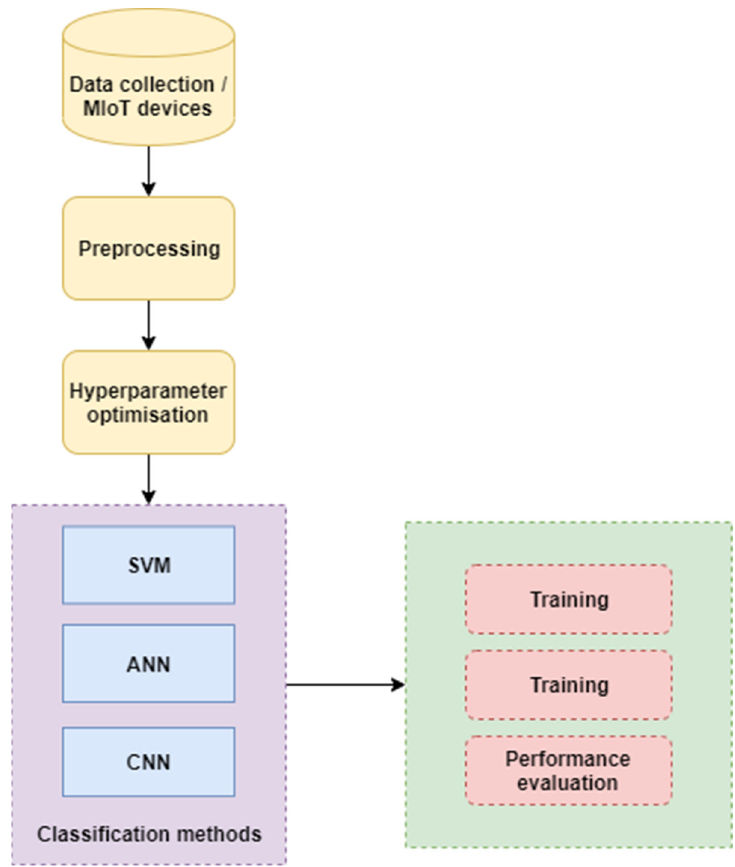
Figure 2. Proposed breast cancer classification architecture .